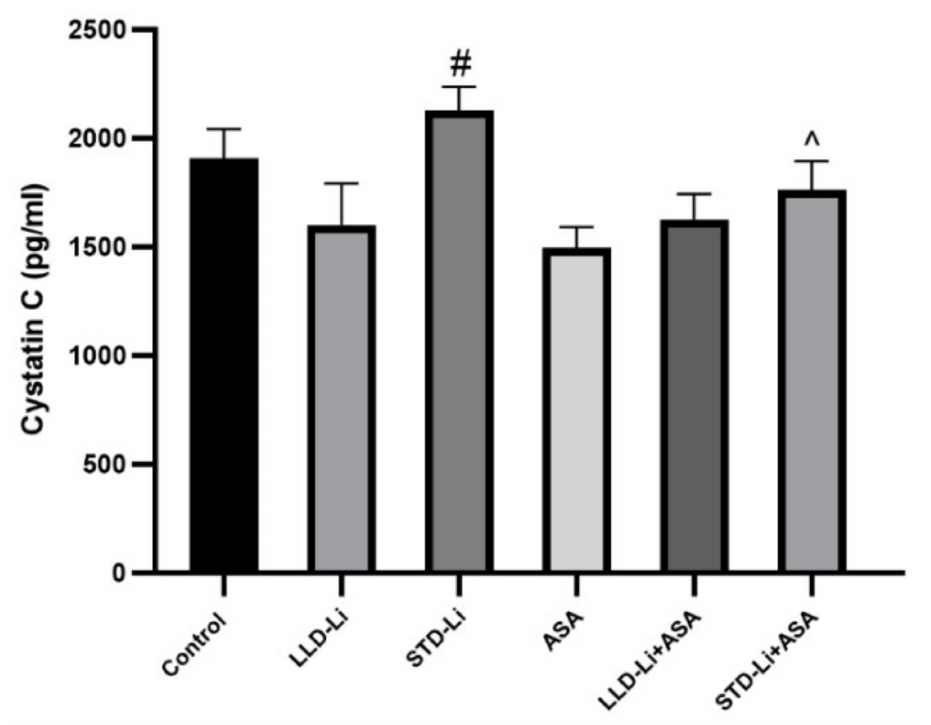
Figure 4. Plasma cystatin C levels in aspirin + Li-treated rats. Rats were fed regular food (control) or lithium-containing food [LLD-Li or STD-Li] for 42 days. Low-dose aspirin (1 mg/kg, ip) was given alone or together with Li. On day 42, rats were euthanized, blood collected, plasma separated, and cystatin C levels determined by ELISA as described in Materials and Methods. Presented are cystatin C levels adjusted to rat’s body weight. Results are the means ± SEM of a single represen- tative experiment out of two demonstrating a similar pattern with 8 rats per group in the depicted experiment. Two-way ANOVA: ASA effect, F 1,40 = 5.801, p = 0.0207; Li effect, F 2,40 = 3.616, p = 0.036; aspirin x Li interaction: F 2,40 = 1.679, p = 0.1995. Post hoc Fisher’s LSD test: Control vs.